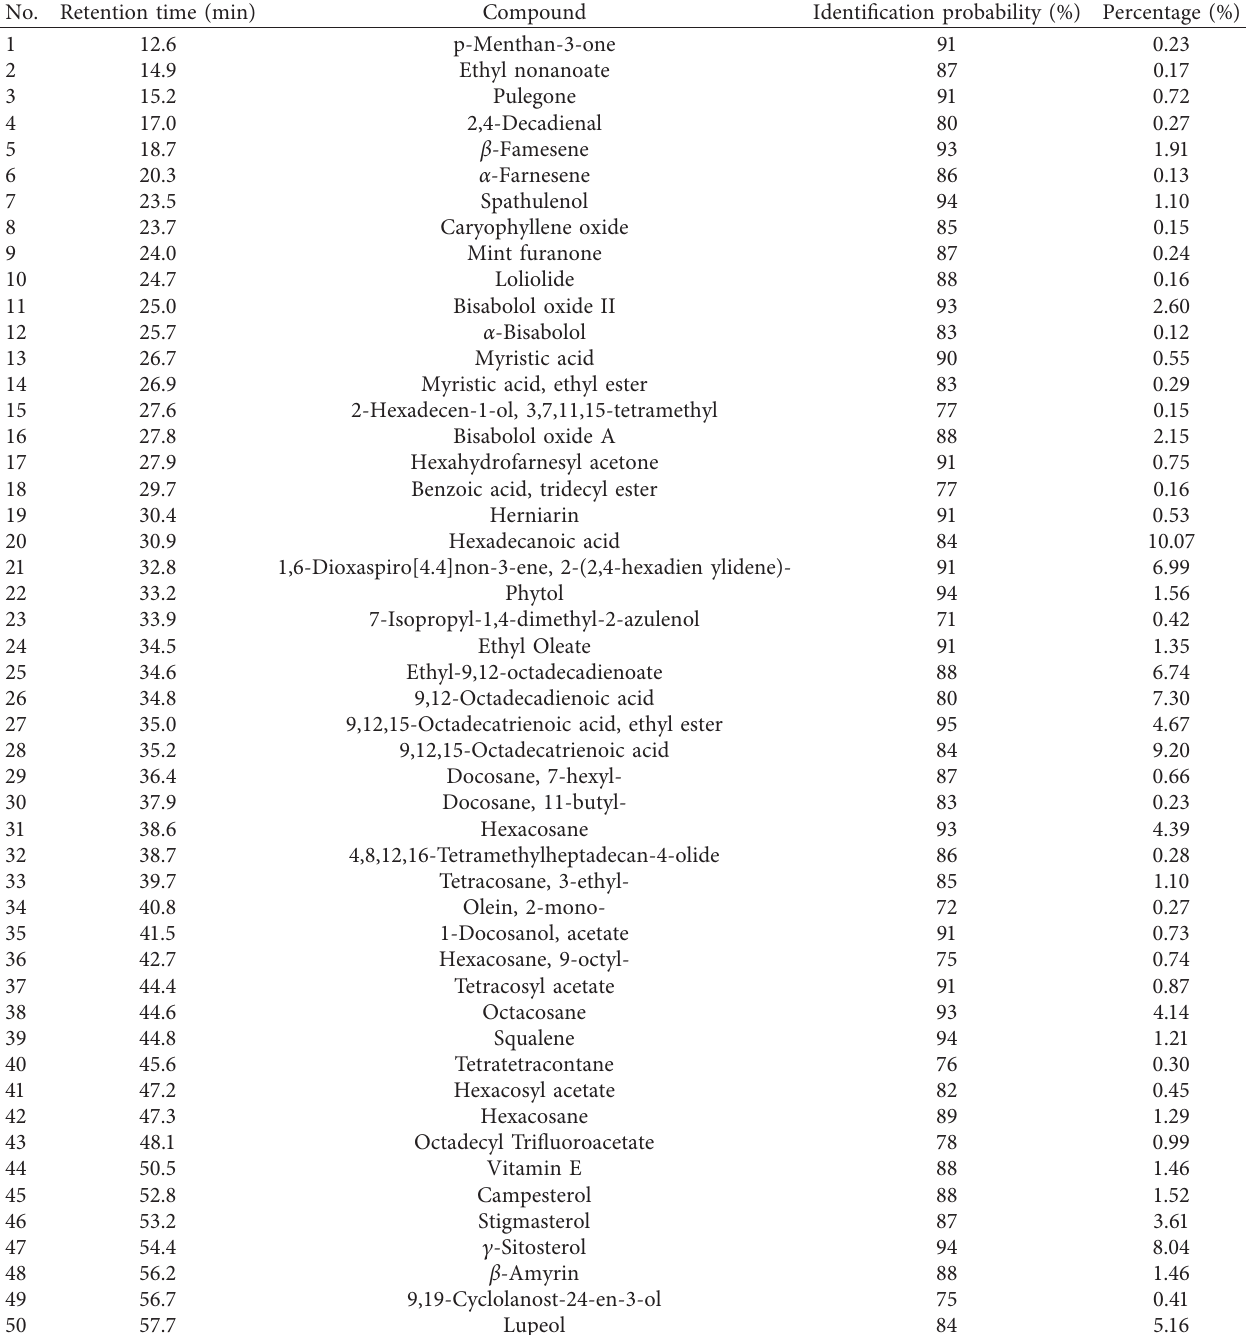
2 extract (Almaty region, Southeast Kazakhstan, 2019).